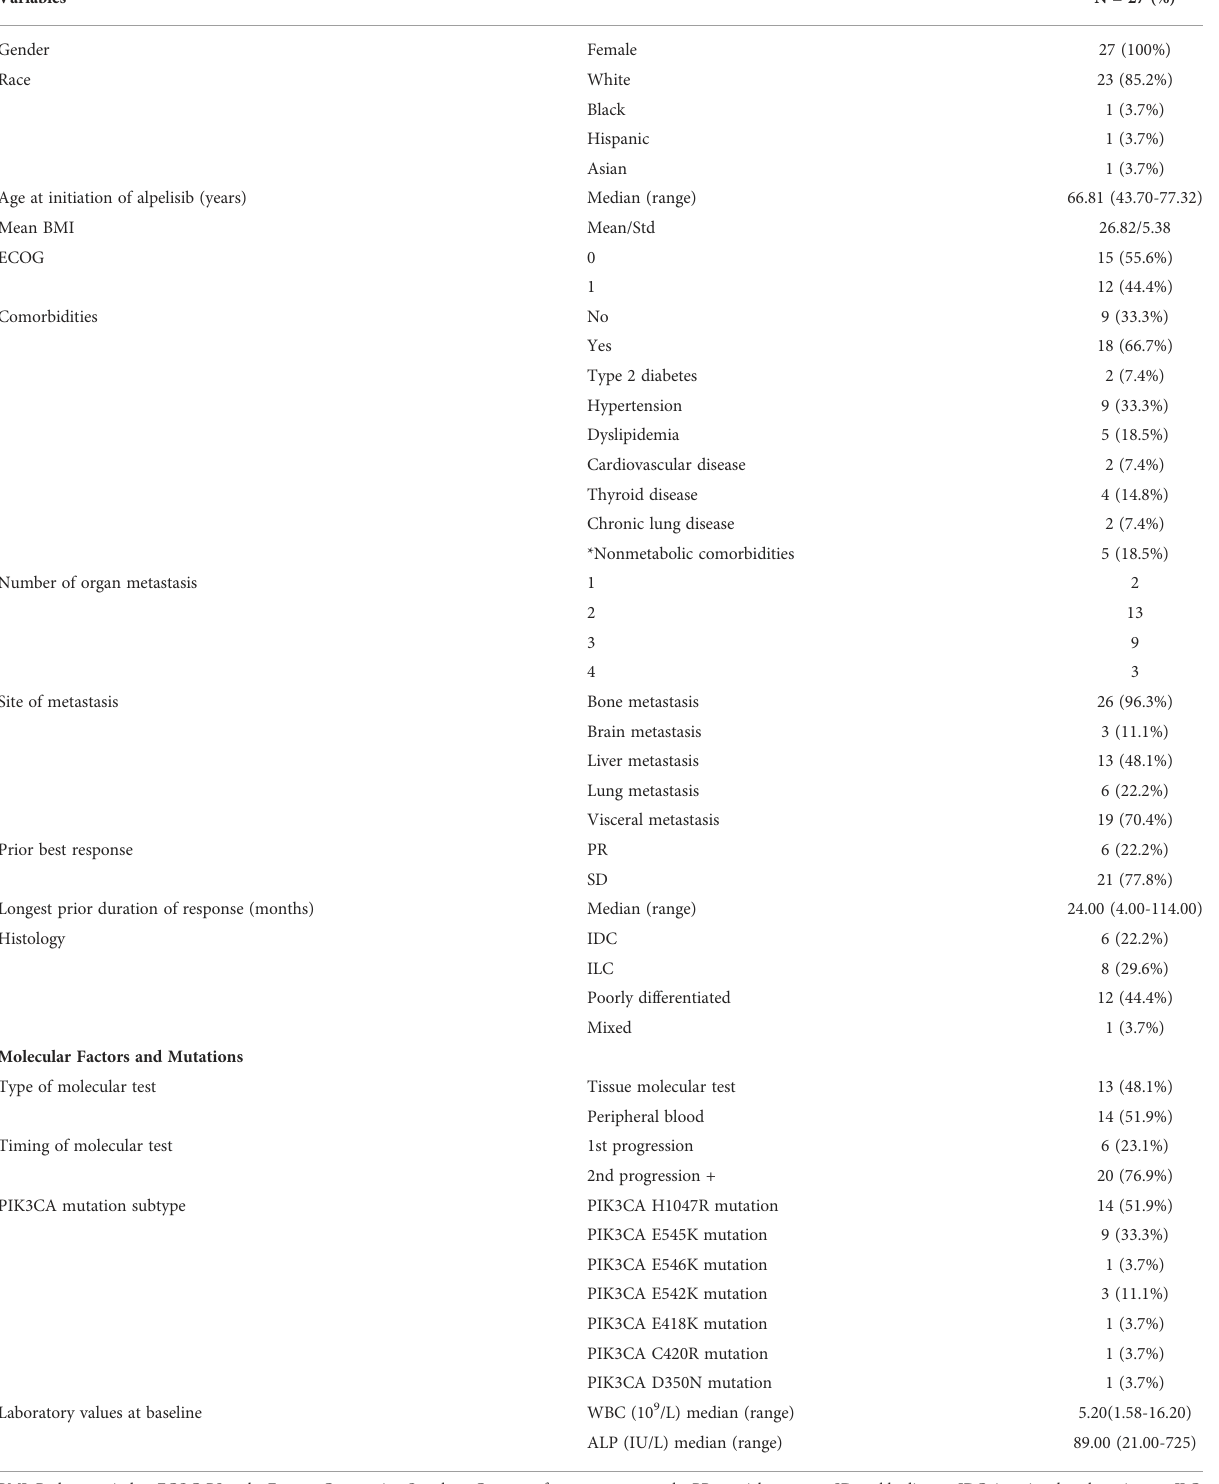
TABLE 1 Baseline clinical/demographic